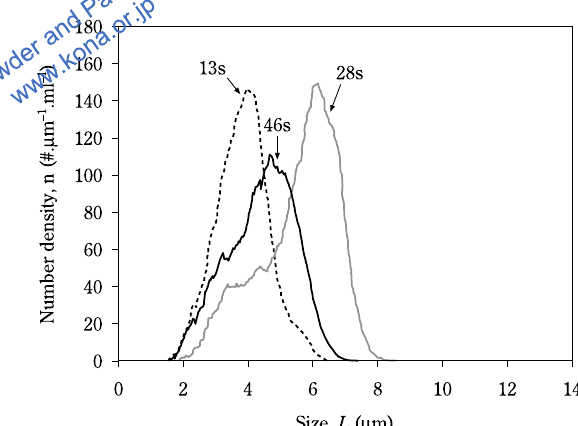
Fig. 5 Particle size distribution of fines in the fluidised bed reactor at various residence times.